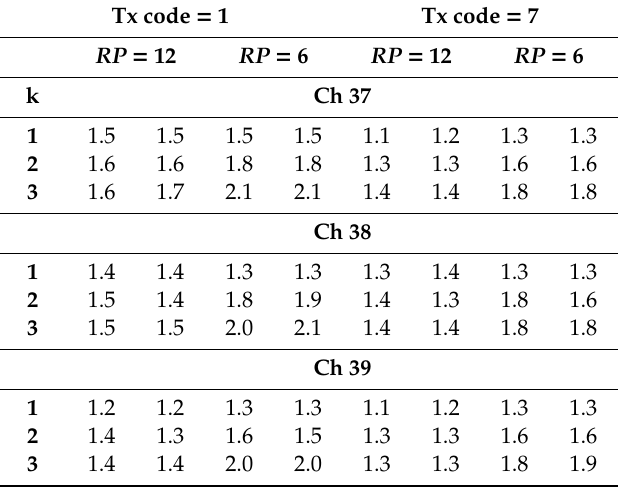
Table 21. Accuracy (in m) for Tests #7. For each number of RP, the first and second data columns refer to the iBeacon and Eddystone protocol respectively. The three advertising channels are referred to as Ch 37, etc., and the number of neighbors in the WKNN algorithm, as k